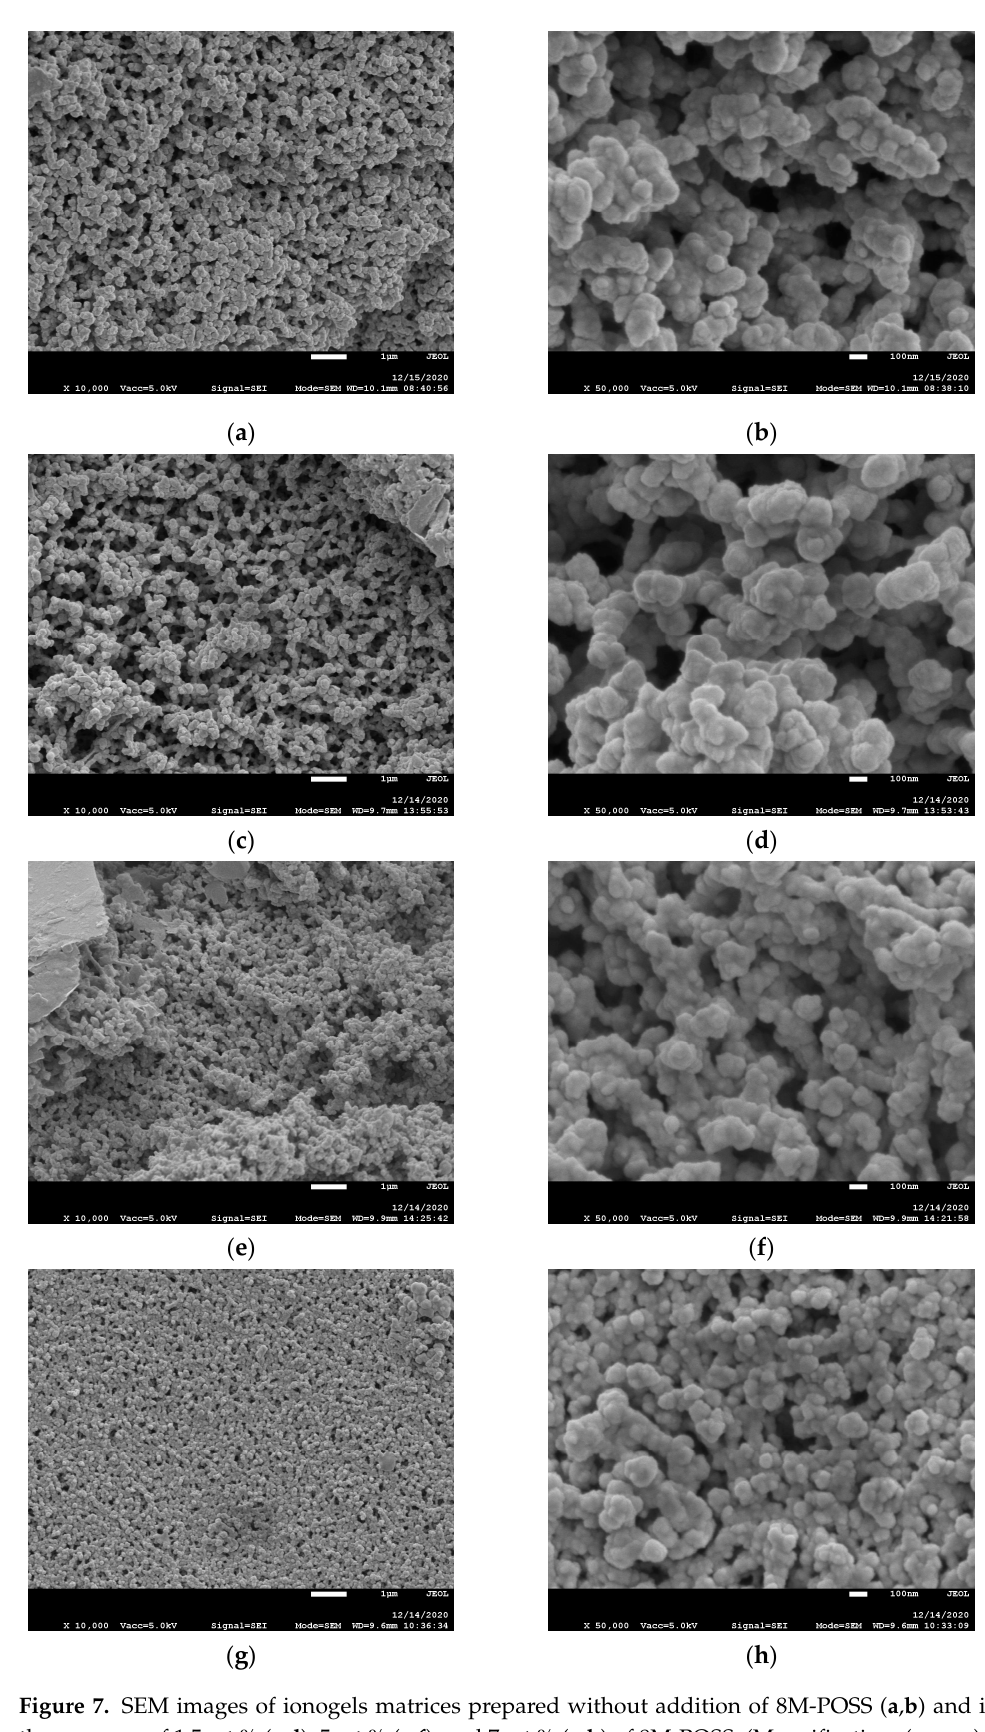
Figure 7. SEM images of ionogels matrices prepared without addition of 8M-POSS ( a , b ) and in the presence of 1.5 wt.% ( c , d ), 5 wt.% ( e , f ), and 7 wt.% ( g , h ) of 8M-POSS. (Magnification: ( a , c , e , g )— 10,000 × , and ( b , d , f , h )—50,000 ×